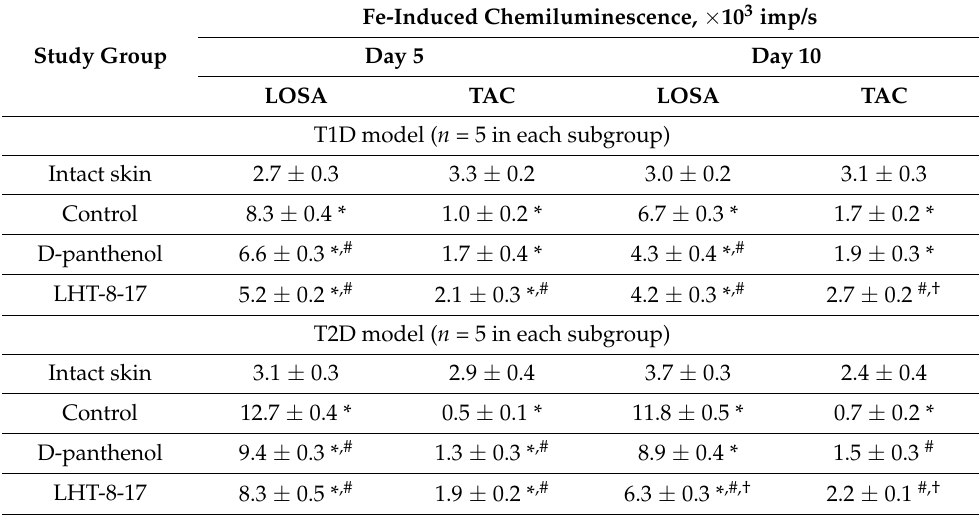
Table 2. Local oxidative stress activity (LOSA) and total antioxidant capacity (TAC) of wound tissue of diabetic mice topically treated with LHT-8-17.